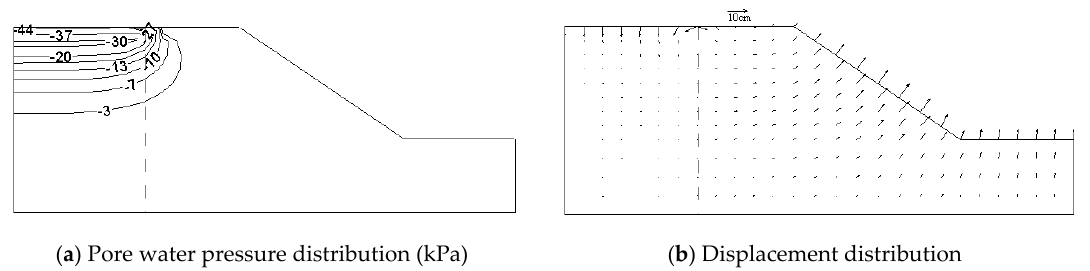
Figure 11. The distributions of pore water pressure and displacement at the end of evaporation with an evaporation rate of 0.1 mm/day.